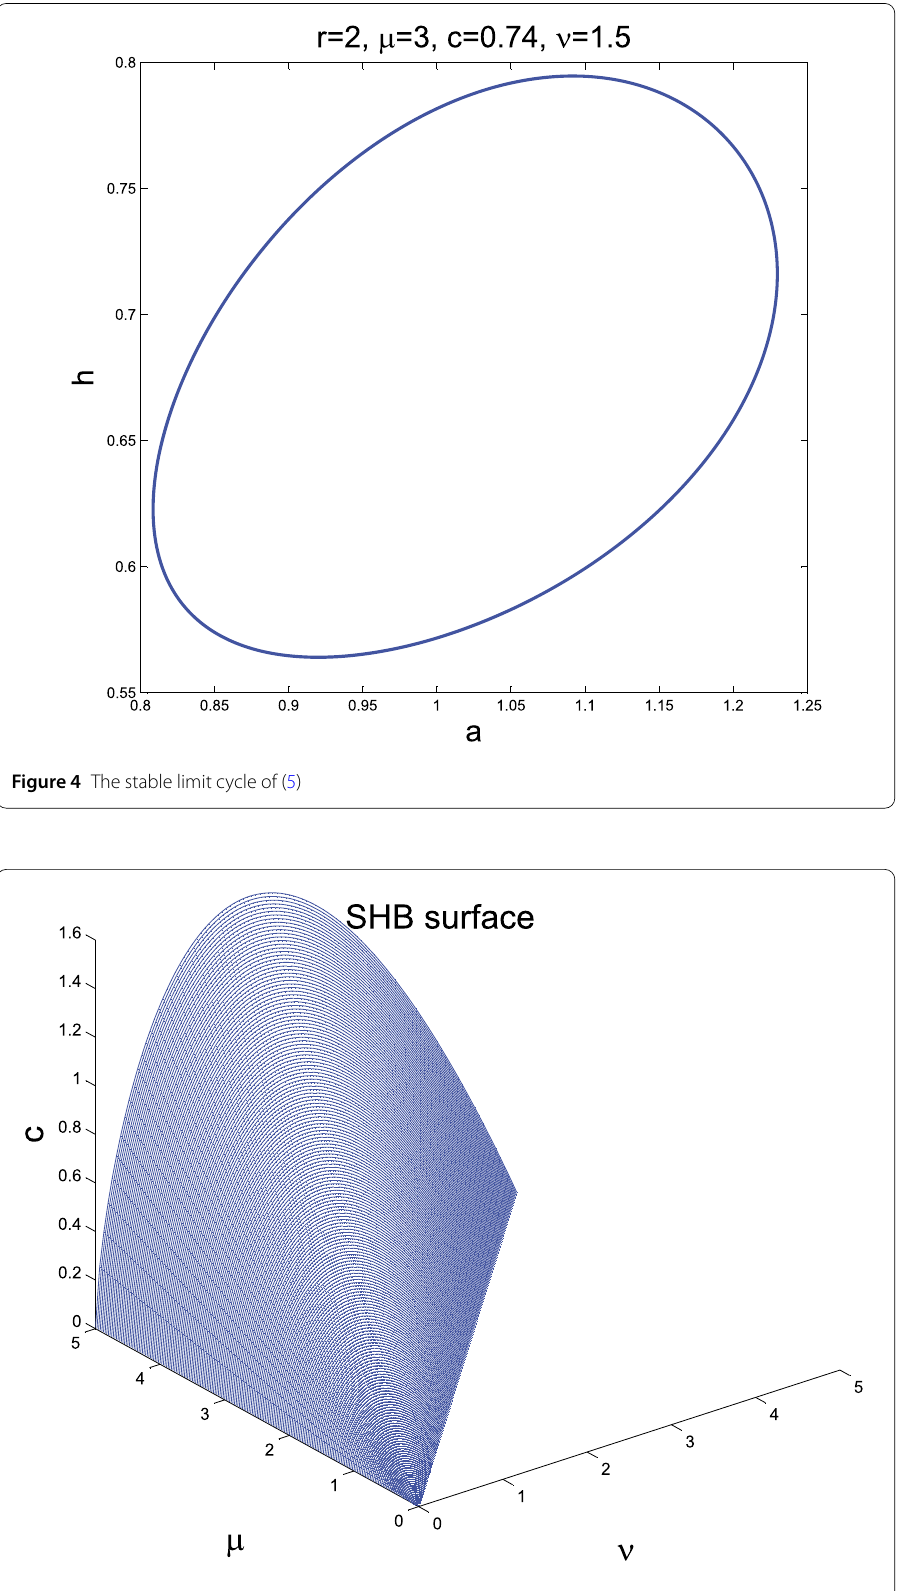
Figure 5 The supercritical Hopf bifurcation (SHB) surface of (5) in parameter space ( ν , μ , c